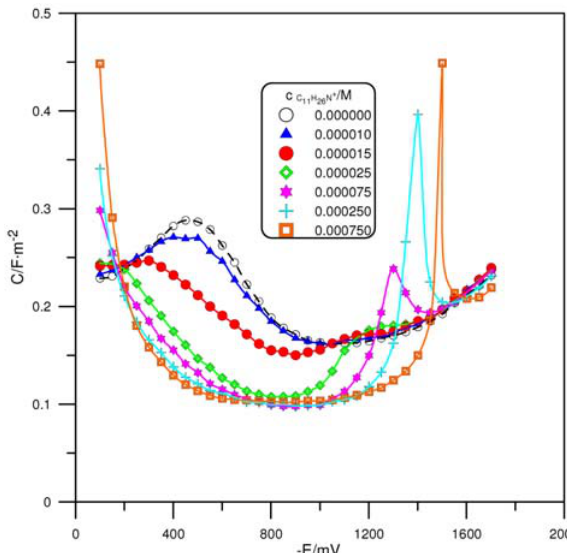
H NBr concentrations. 11 26